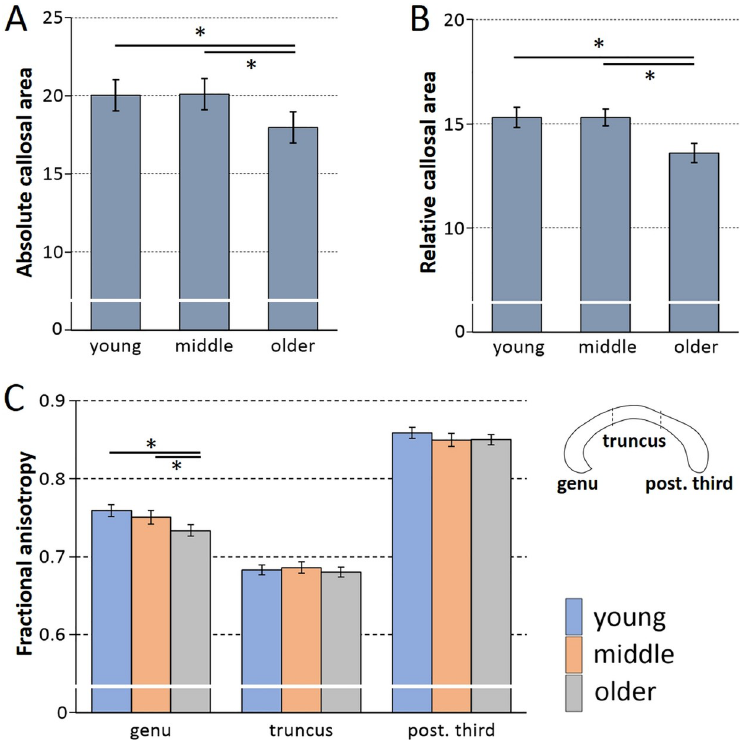
Fig 2. Aging and the corpus callosum. Mean absolute area (A), relative area (i.e., area/tIV 0.667 ratio) (B), and fractional anisotropy, FA, (C) of the corpus callosum for the three age groups (error bars indicate CI 95% ). Panel (A) shows the main effect of age group, indicating a decrease in midsagittal area in the oldest compared to the two other groups. The y-axis provides the mean area measures across the three callosal subregions (in mm 2 � 0.111). Panel (B) shows the main effect for relative area (as average across subregions) with again the oldest group differing from the two others. Panel (C) shows the age group FA means for each of the callosal subregions. Comparable to what was found for the two other parameters, also in the FA analysis the main effect of age was significant. However, an also significant age group by subregion interaction together with post-hoc testing revealed the age effect only to be significant in the